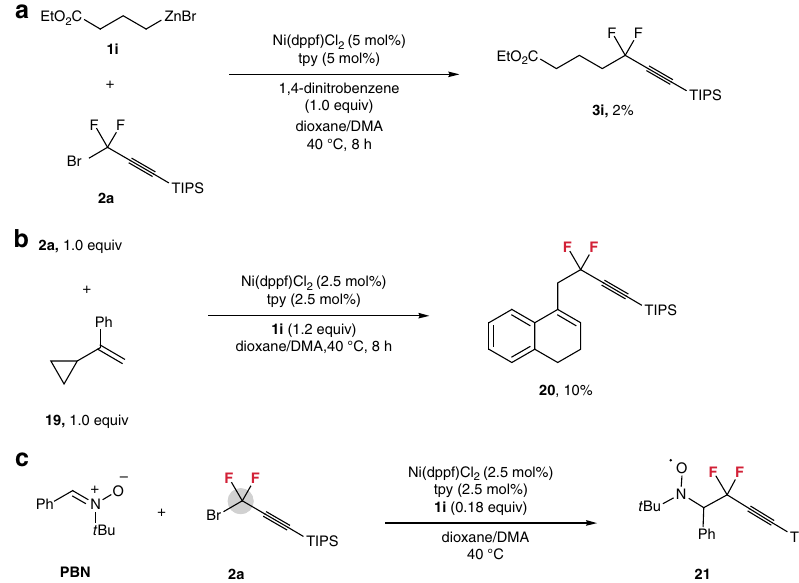
Fig. 2 Gem -di fl uoropropargyl radical trapping experiments. a Radical-inhibition experiment. b Radical clock experiment. c EPR